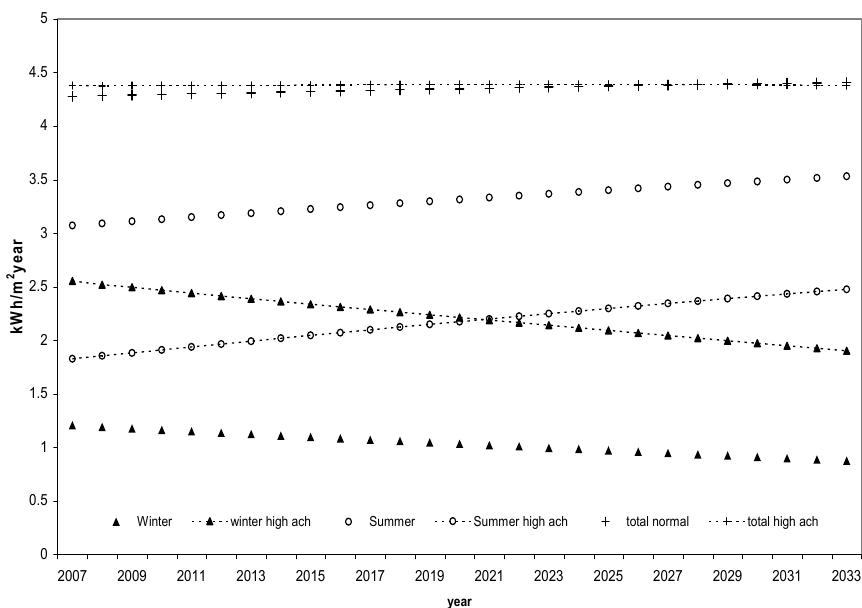
Figure 7. Reduction in energy consumption peer year and different ach values (kWh/m 2 year).